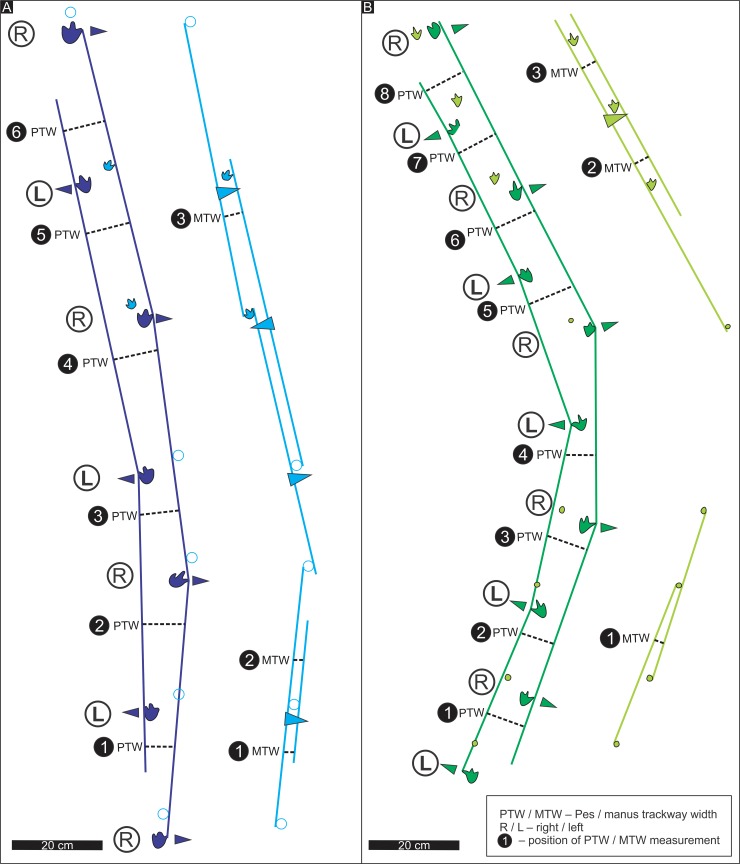
Position of the width measurements taken from the pes and manus trackways.(A) Highlands trackway A. (B) Chewore trackway. Chewore trackway modified and republished from Lingham-Soliar and Broderick [74] under a CC BY license, with permission from Taylor & Francis, original copyright 2000. Triangular arrows point away from the trackway midline.